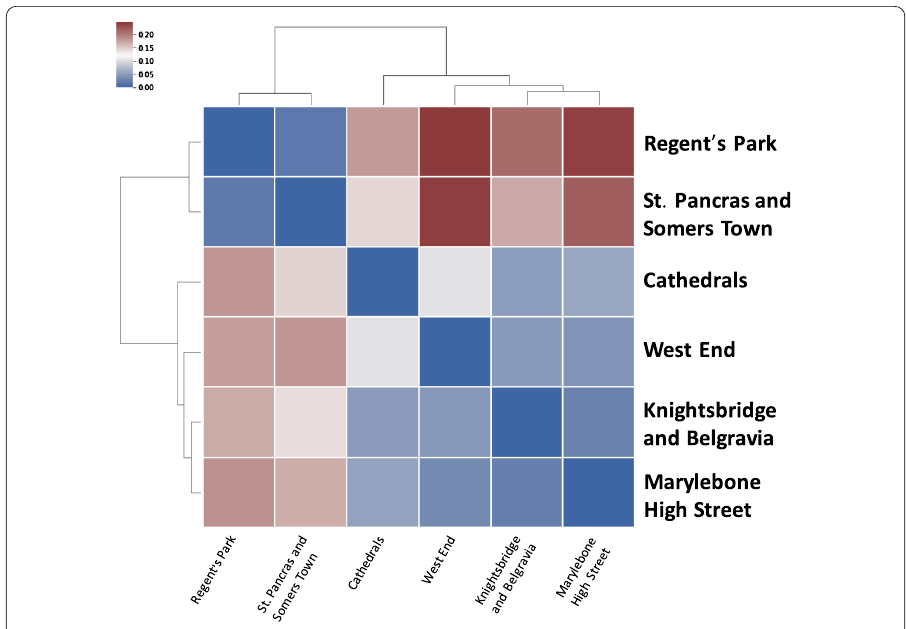
Figure 4 Temporal similarity of wards. J-S divergence of the characteristic weekly temporal profile of the 15 most popular wards. Smaller values signify a smaller divergence and thus more similarity